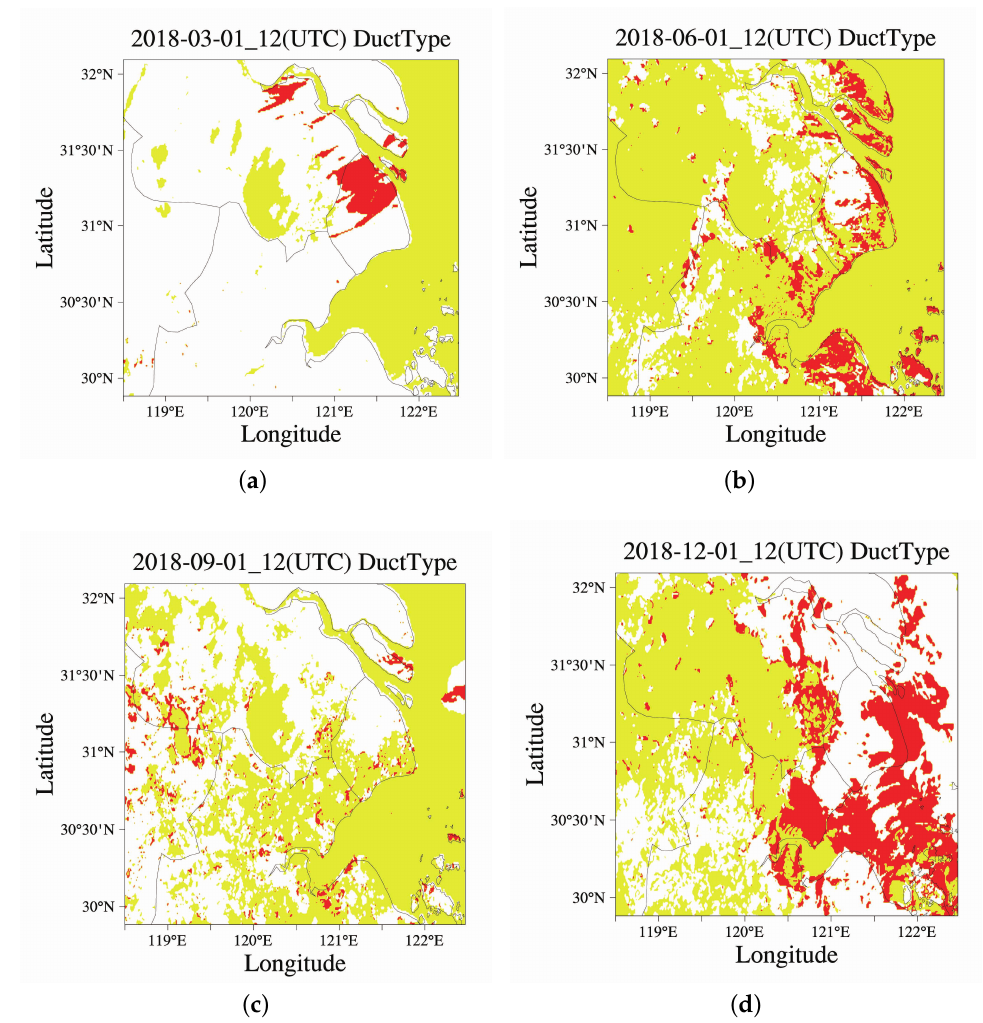
Figure 3. The distribution of ducts in selected plain areas by seasons, where the yellow area represents the surface duct and the red area represents tge elevated duct. ( a ) March. ( b ) June. ( c ) September. ( d )